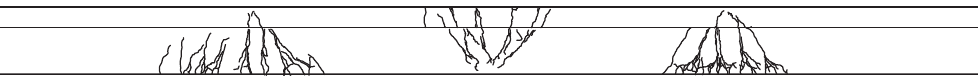
Figure 21: Cracks in test beam ZCB-2.